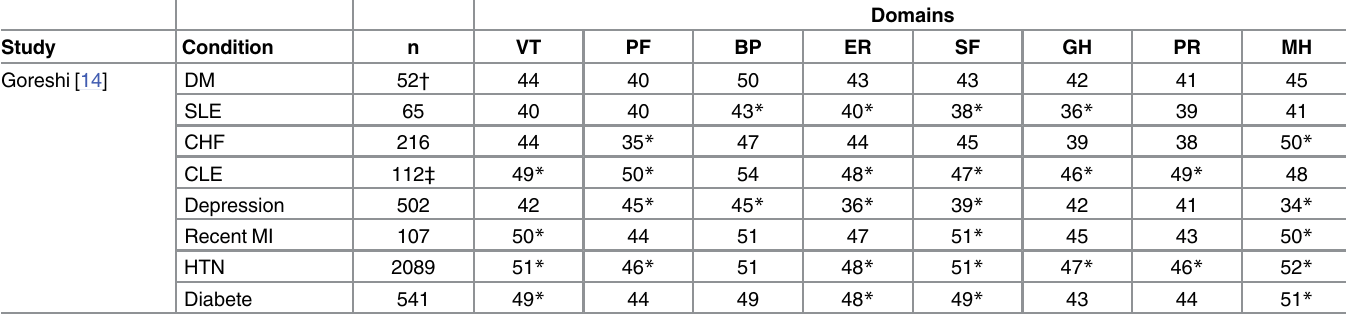
Table 4. Comparison of HRQoL between IIM and other chronic conditions using the